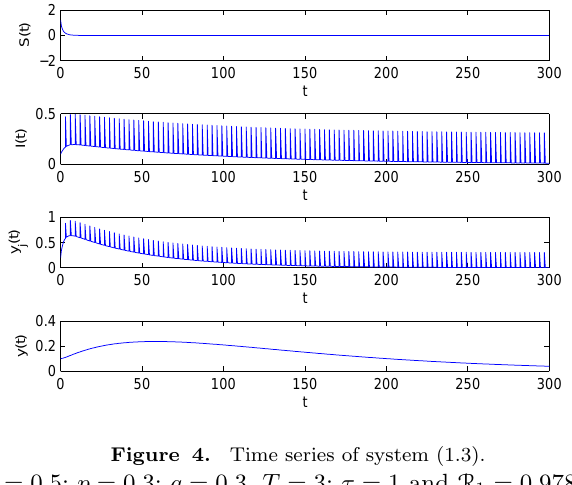
Figure 4. Time series of system (1.3).